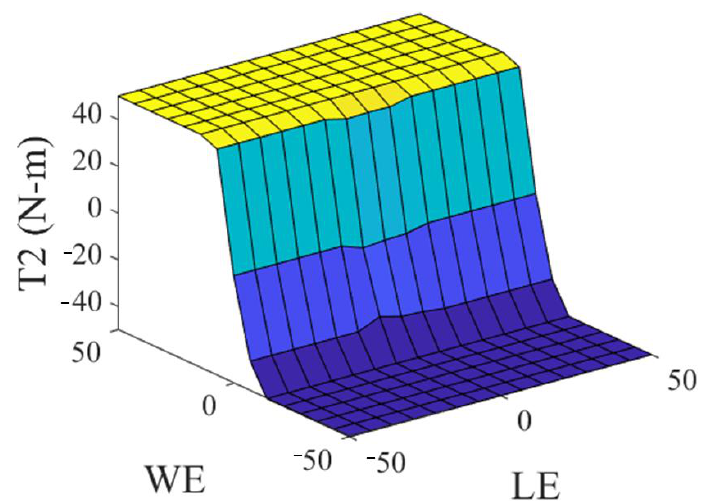
Figure 6. Consequent of the GT2FC.